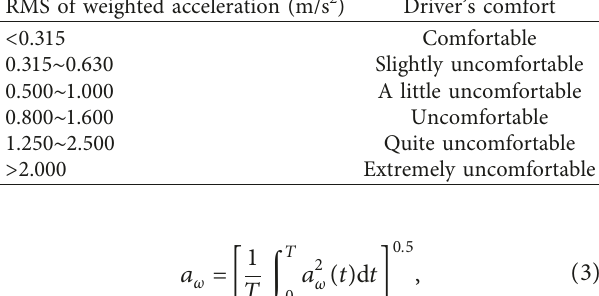
Table 2: Relationships between driving comfort and RMS of weighted